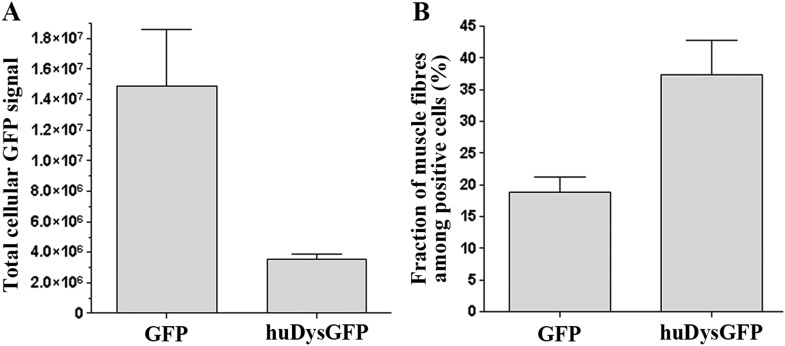
Comparison of huDysGFP and GFP expression in 2 dpf zebrafish embryos.(A) Total cellular GFP signal (sum of pixel values) of sum projections made from confocal optical sections of individual muscle fibres expressing GFP or huDysGFP in vivo. NGFP = 10 fibres, NhuDysGFP = 32 fibres; p < 0. 0001. (B) Fraction of muscle fibres among positive cells in embryos expressing huDysGFP or GFP in vivo. NGFP = 1593 cells in 27 embryos, NhuDysGFP = 472 cells in 28 embryos; p = 0. 0032. Error bars show S.E.M.